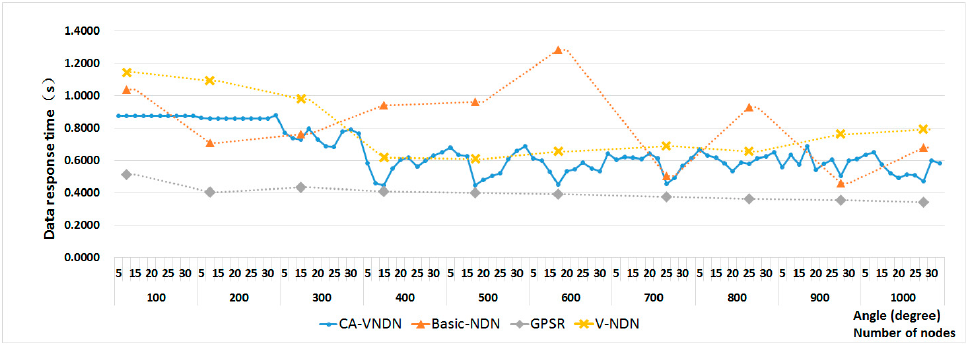
Figure 16. Average data response time vs. the number of nodes and suppression angle.